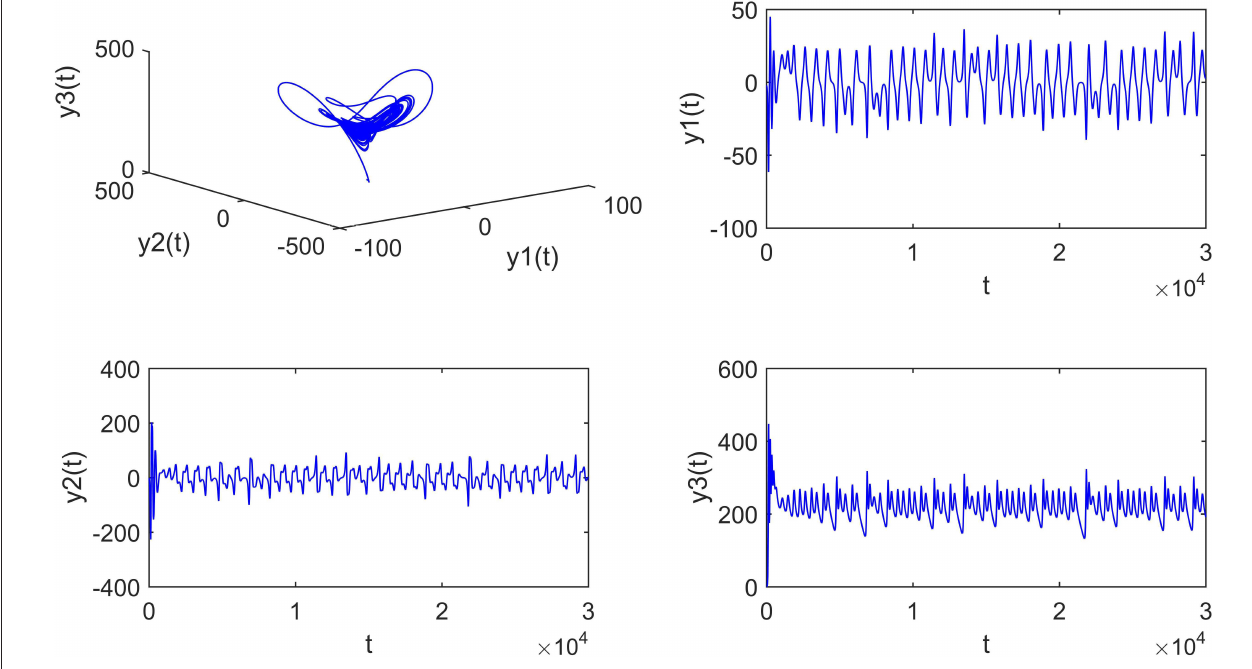
FIGURE 3 | Dynamic behavior of FOPMSM.